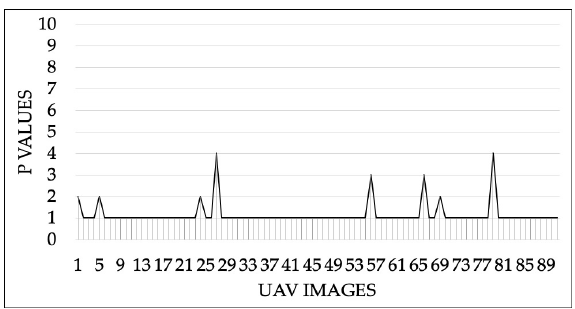
Figure 11. The experimental result of adjusting the variable p of the image